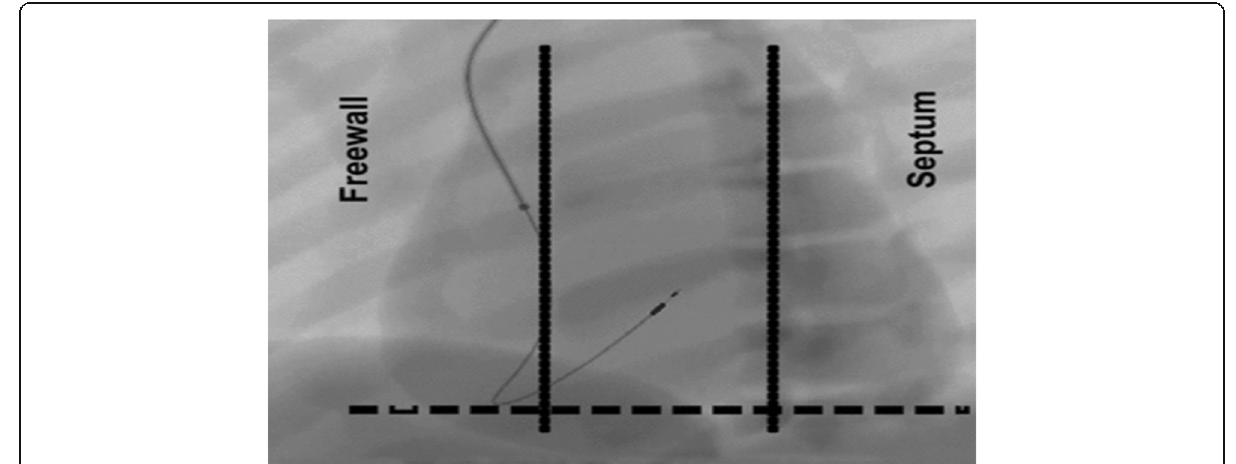
Fig. 2 LAO 40 view to differentiate lead placement on the RV septum from the RV free